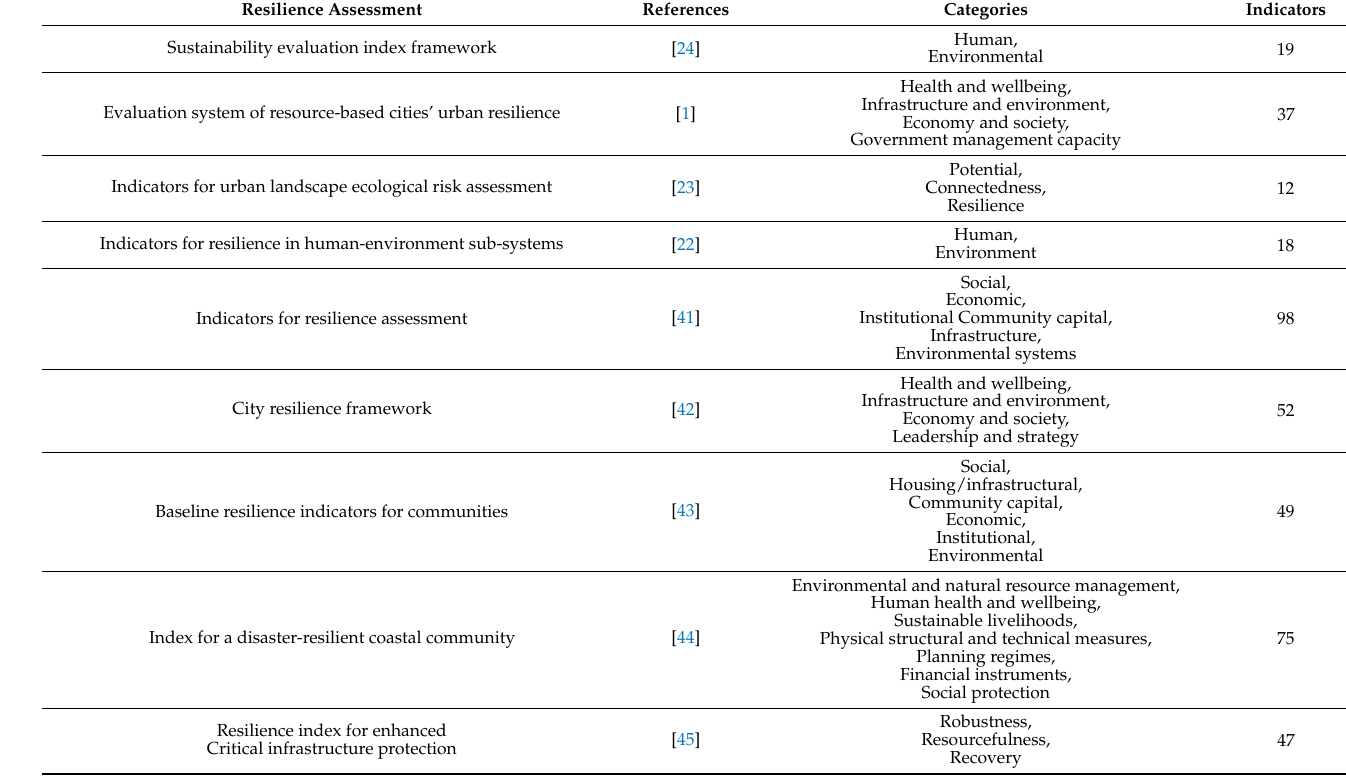
Table 1. References of selecting resilience indicators for RBCs.